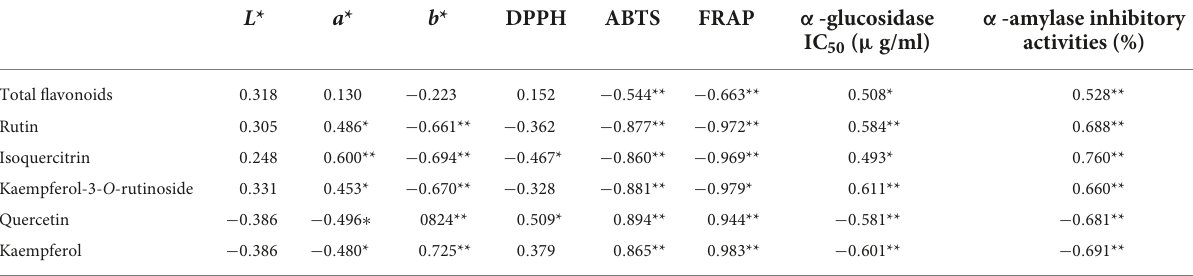
α -amylase inhibitory IC 50 ( µ g/ml) activities (%)